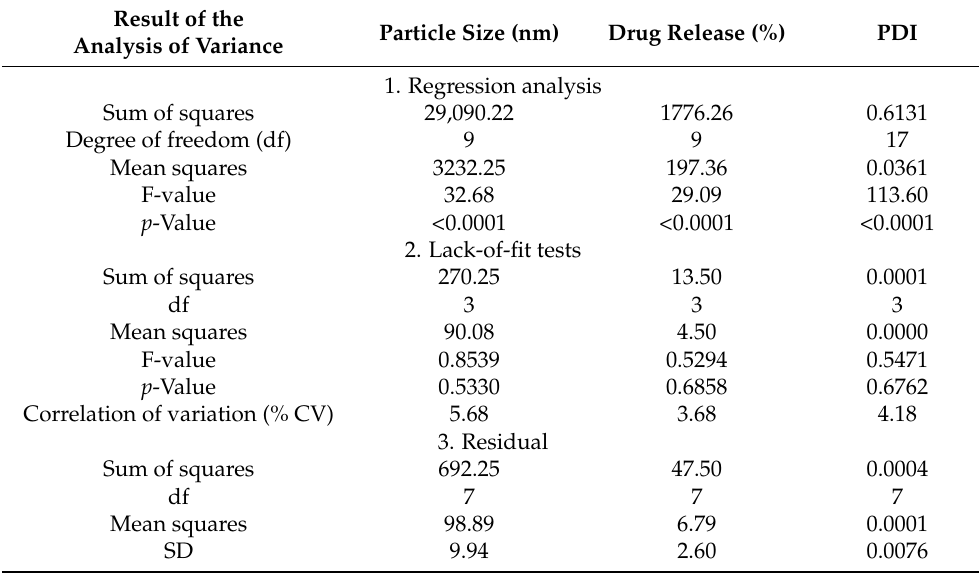
Table 4. Analysis of variance (sum of square, degree of freedom, mean square, F-value, and p -value) for response, particle size, drug release, and